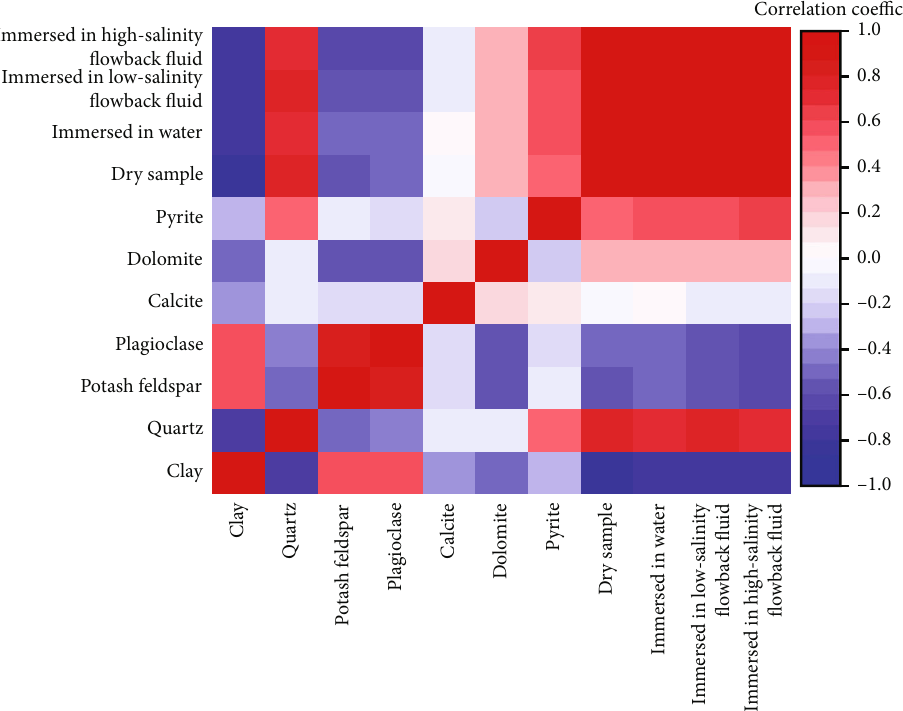
Figure 5: Correlation between rock mineral types and Brinell